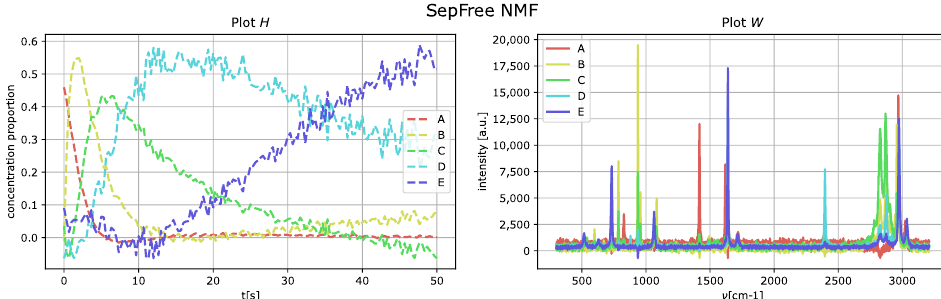
Figure 6. Reconstructed component-spectra of the compounds W on the right and reaction kinetics H on the for noise level η = 0.4 and 30% increased interference of the synthetic Raman dataset. Parameter set [ − 0.001, − 10.0,1.0,0.0,0.0 ] . Minimal memory effect det ( S ) = 0.0005.